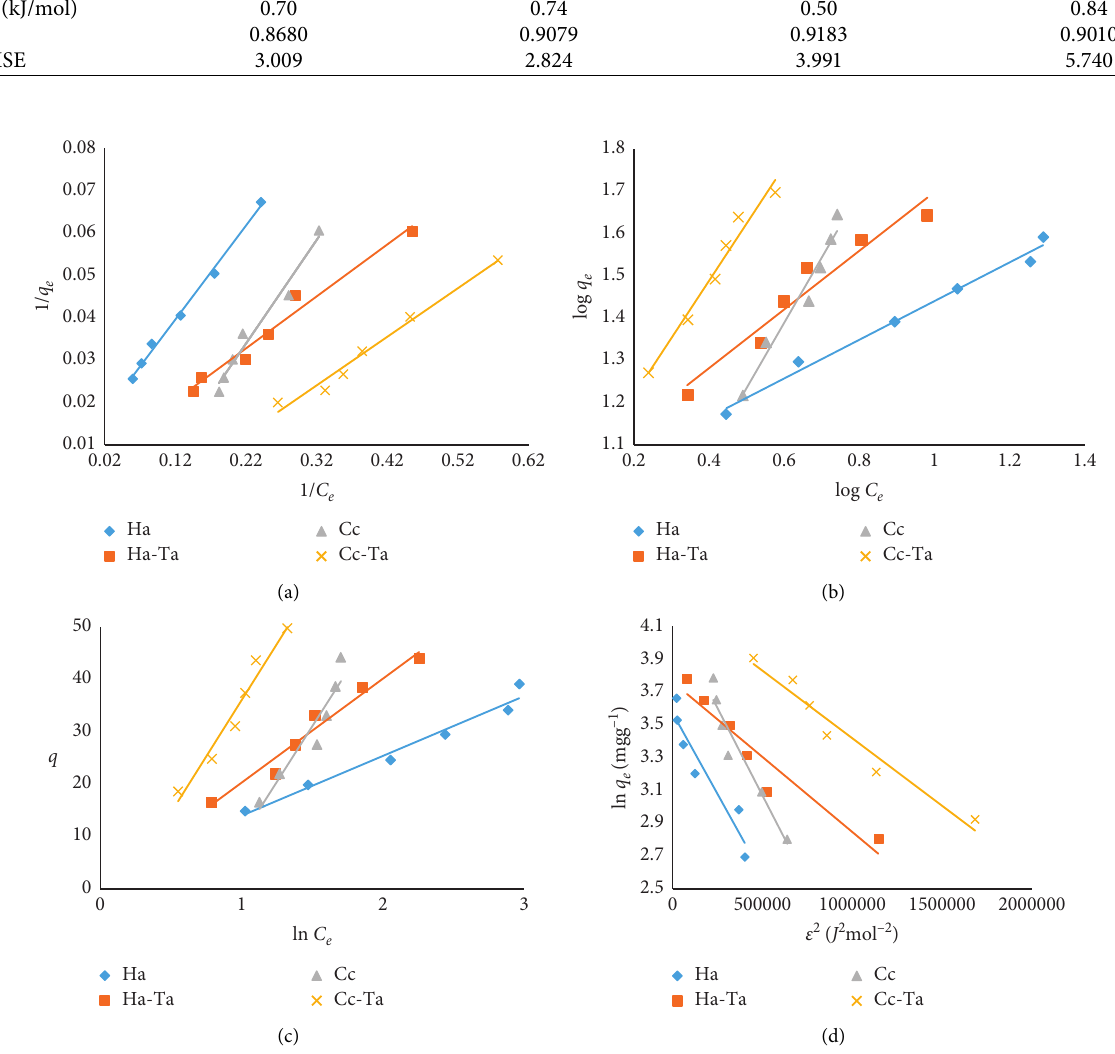
Figure 5: Comparative representation of (a) Langmuir, (b) Freundlich, (c) Temkin, and (d) D-R isothermal